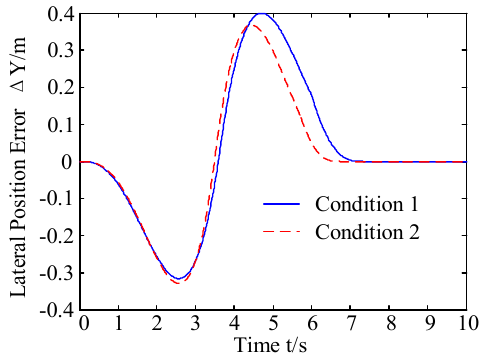
Figure 4. Error of prediction trajectory and reference trajectory of obstacle.